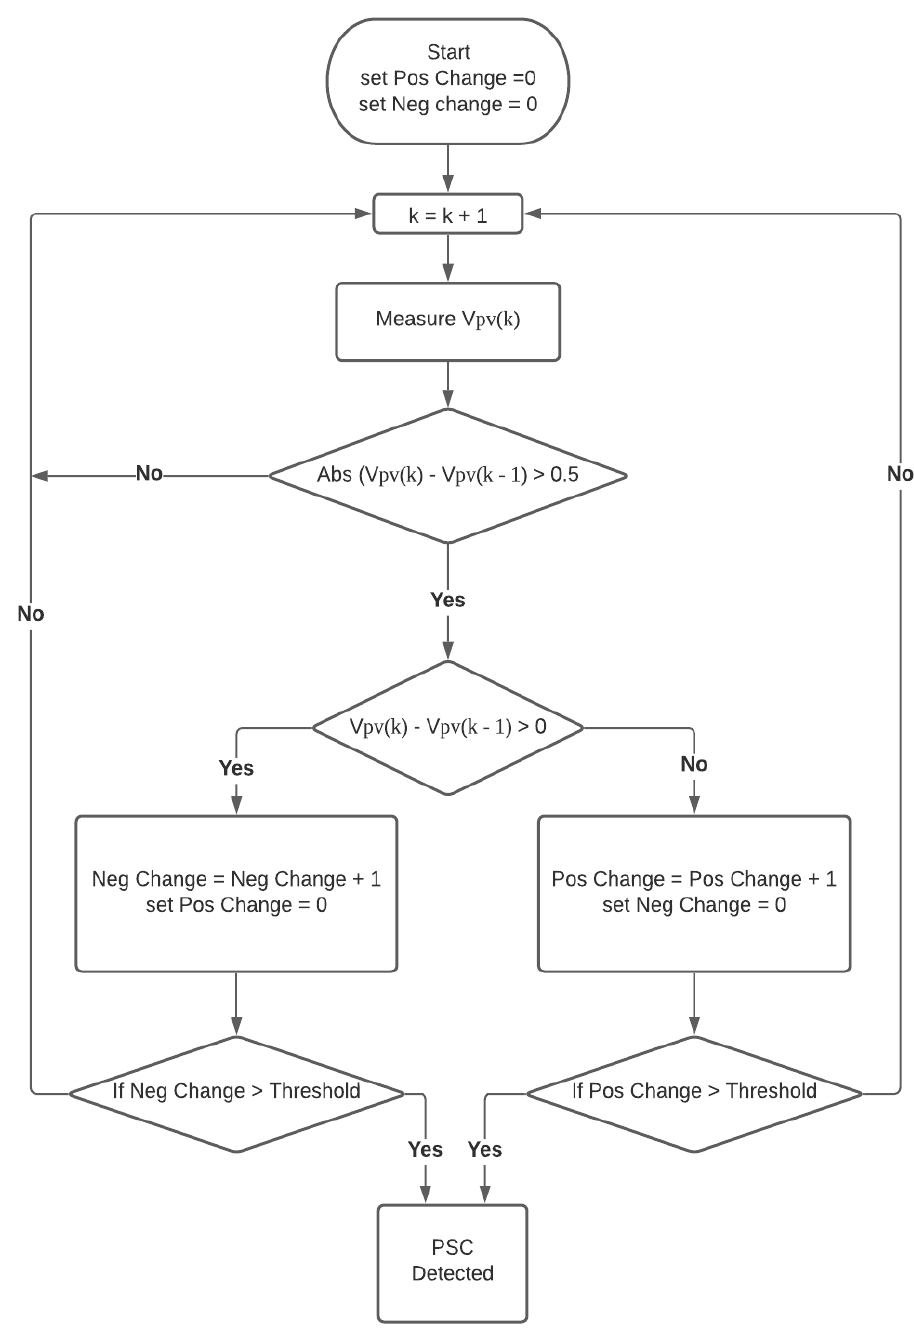
Figure 3. The flowchart of the proposed method.